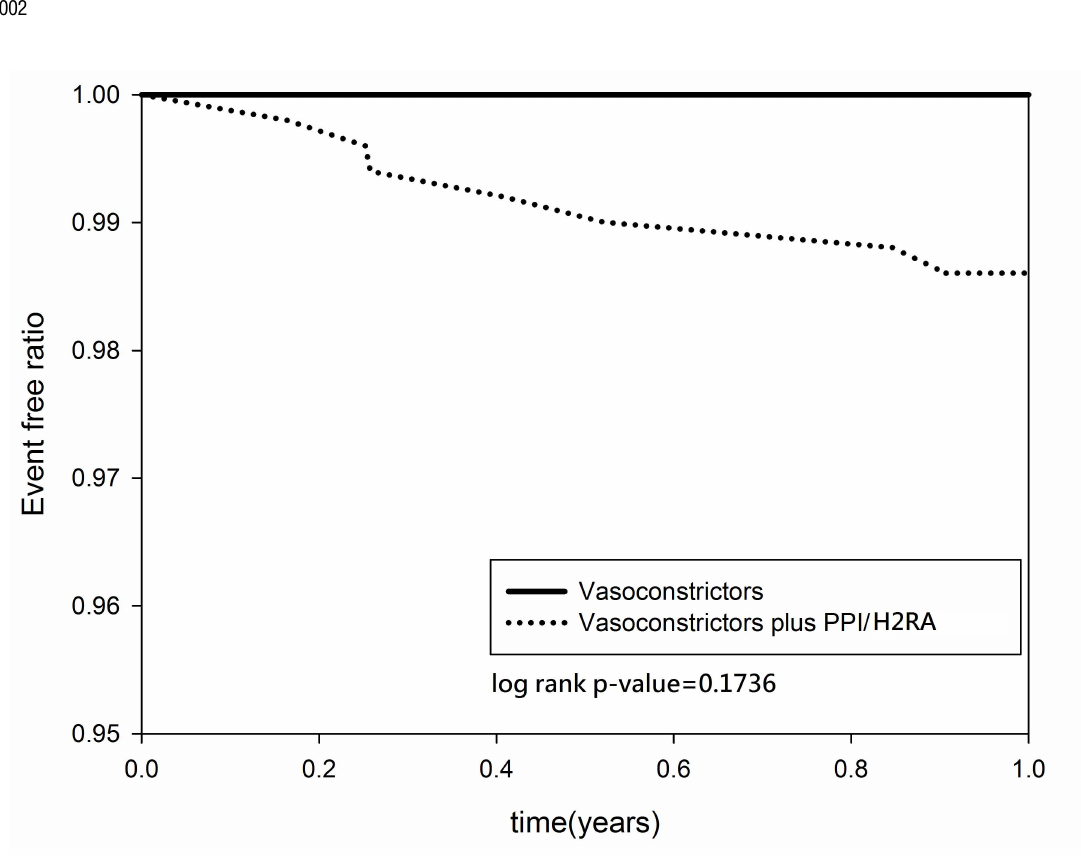
Fig 2. Kaplan–Meier estimates for the absence of re-bleeding in patients with cirrhosis and esophageal variceal bleeding (1 year follow-up).